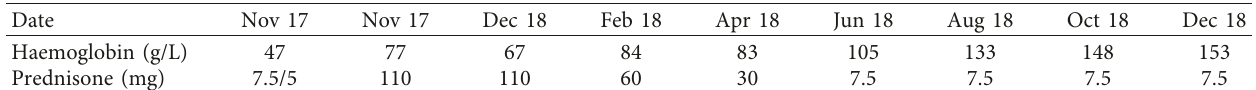
Figure 1: Line graph depicting improvement in haemoglobin despite decreasing prednisone dose following the introduction of danazol. Table 1: Depicting figures of haemoglobin and prednisone as shown in Figure 1. Haemoglobin figures stated in November 2017 are pre- and